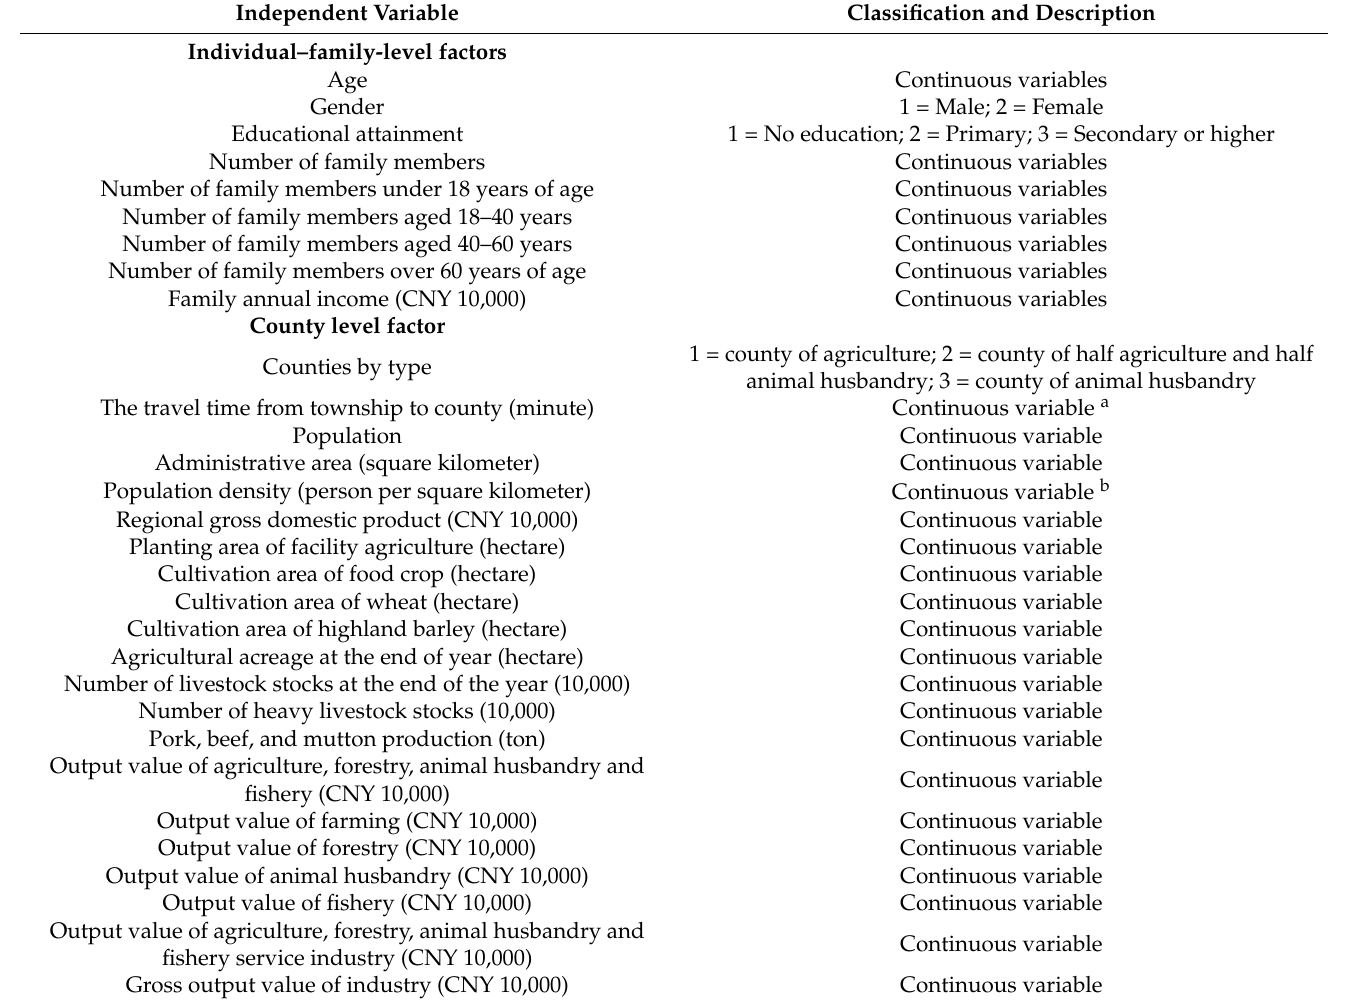
Table 2. Classification and description of potential confounding factors related to food consumption score for the study